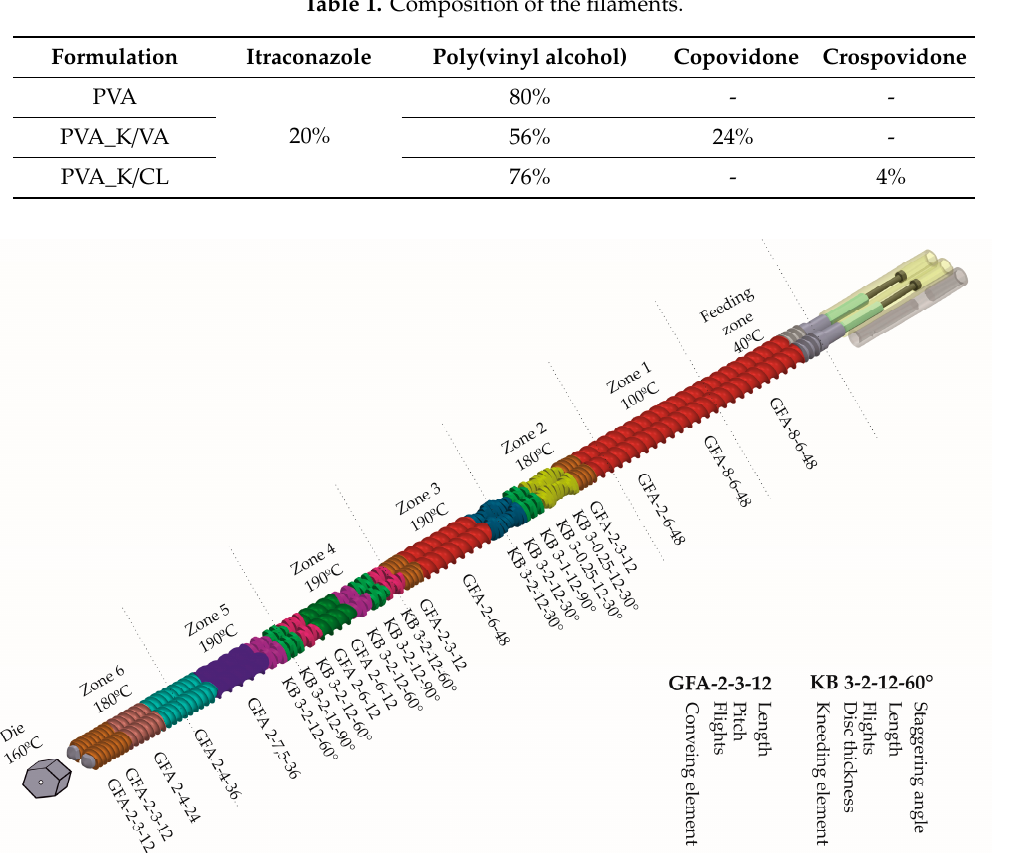
Figure 1. Screw configuration and temperature profile.